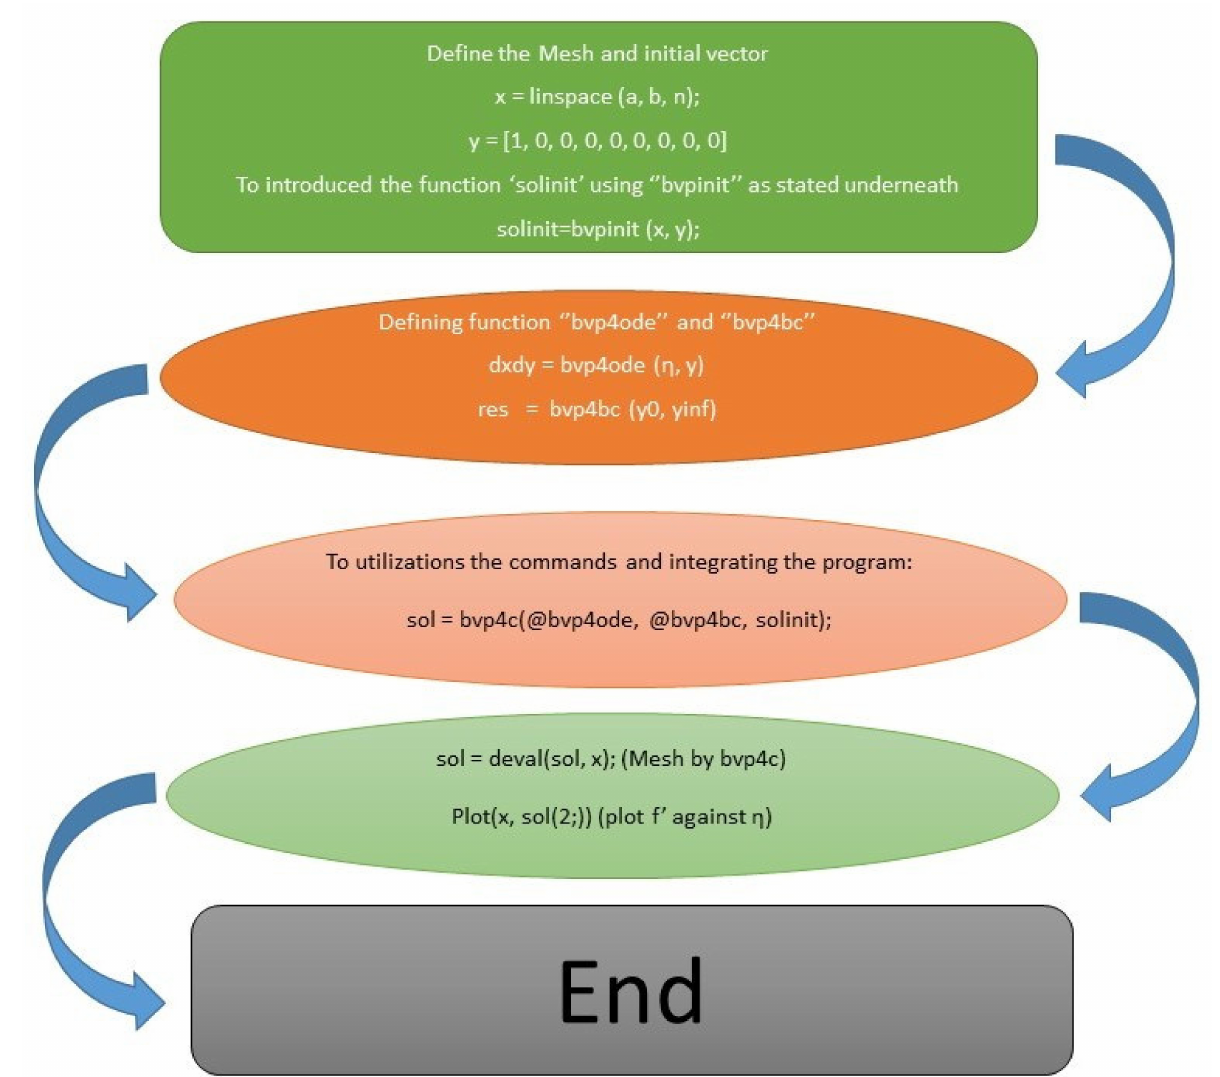
Figure 2. Description of the numerical